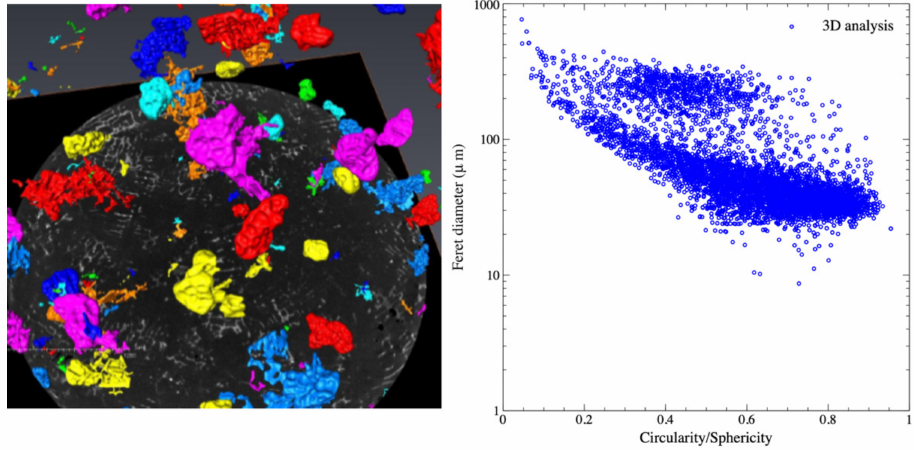
Figure 12. Example of pore detection by X-ray tomography for the studied AlSi7Cu0.5Mg0.3 lost foam cast alloy and pore population ranked by size and